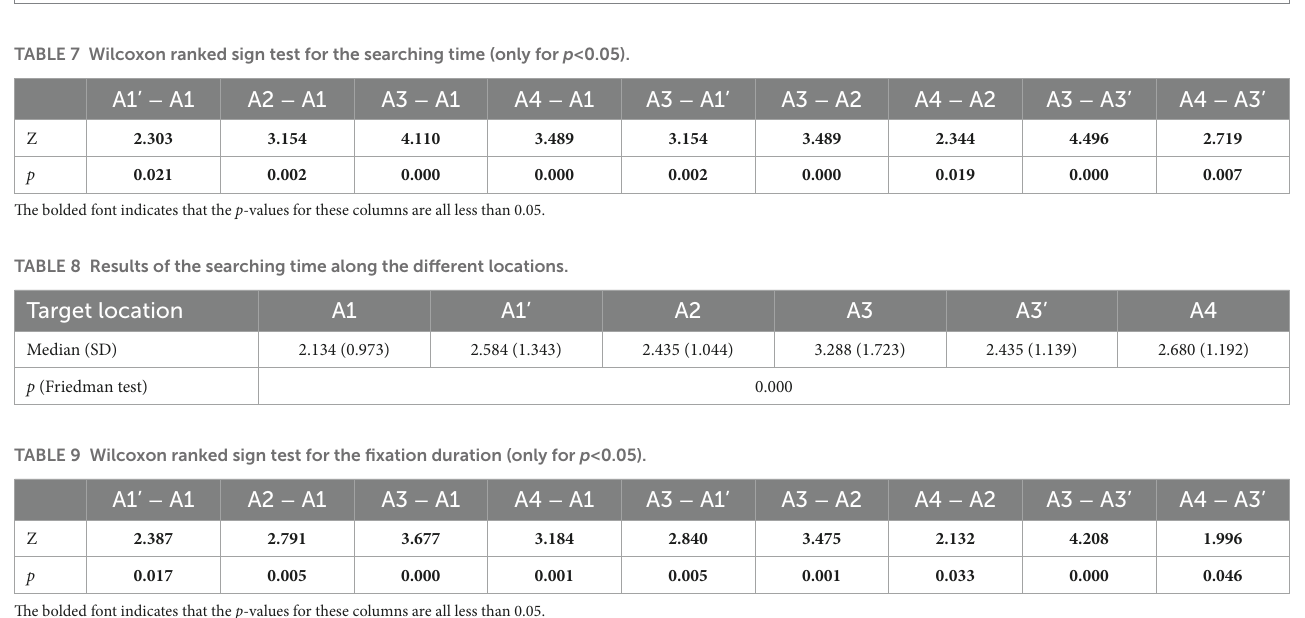
The bolded font indicates that the p -values for these columns are all less than 0.05.